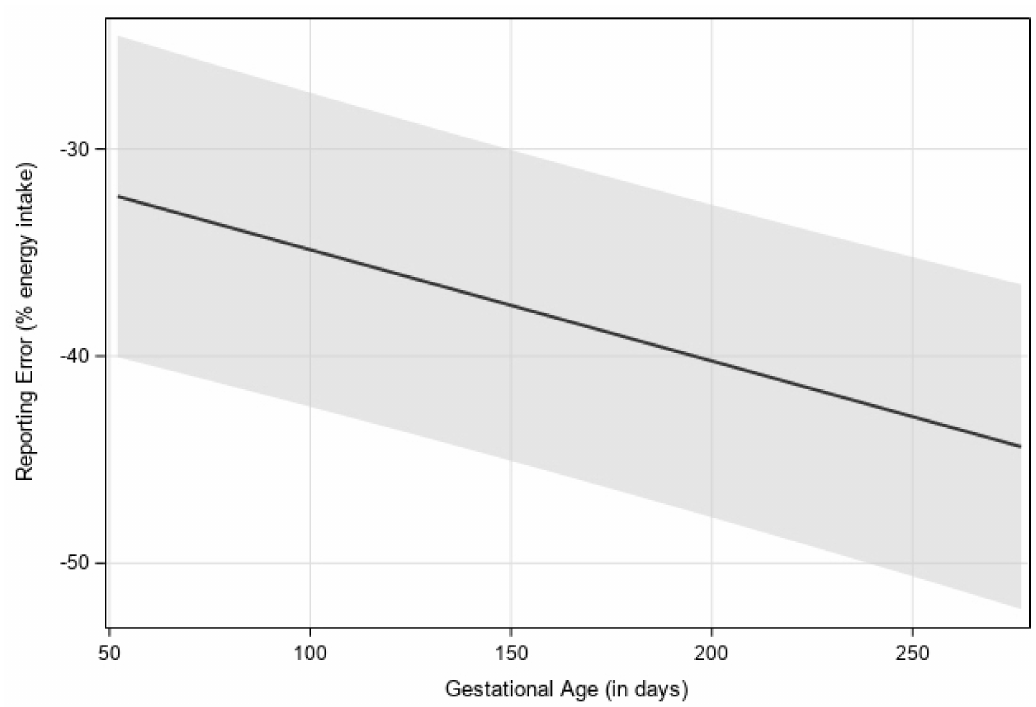
Figure 1. Visualization of estimated reporting error over gestational age (in days), with 95% confi- dence interval. Estimates were generated by using multilevel modeling (SAS PROC MIXED). Linear, quadratic, and cubic effects of gestational week were considered, with a linear relationship having the best model fit.